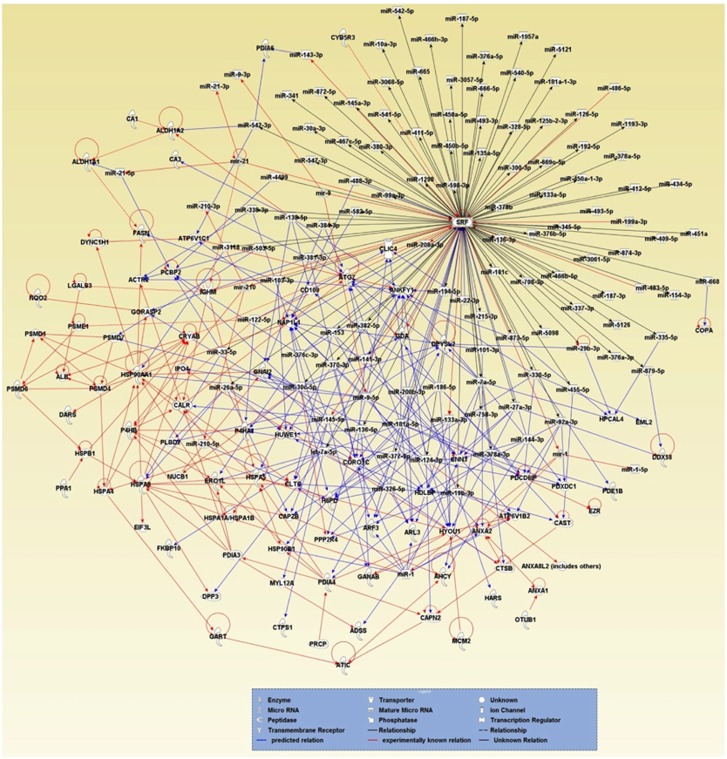
Interactions of SRF-dependent miRNAs and upregulated proteins. Interactions between SRF-dependent miRNAs and upregulated proteins were analyzed using IPA. Note that the SRF-dependent miRNAs target the upregulated proteins in Srf KO SMCs